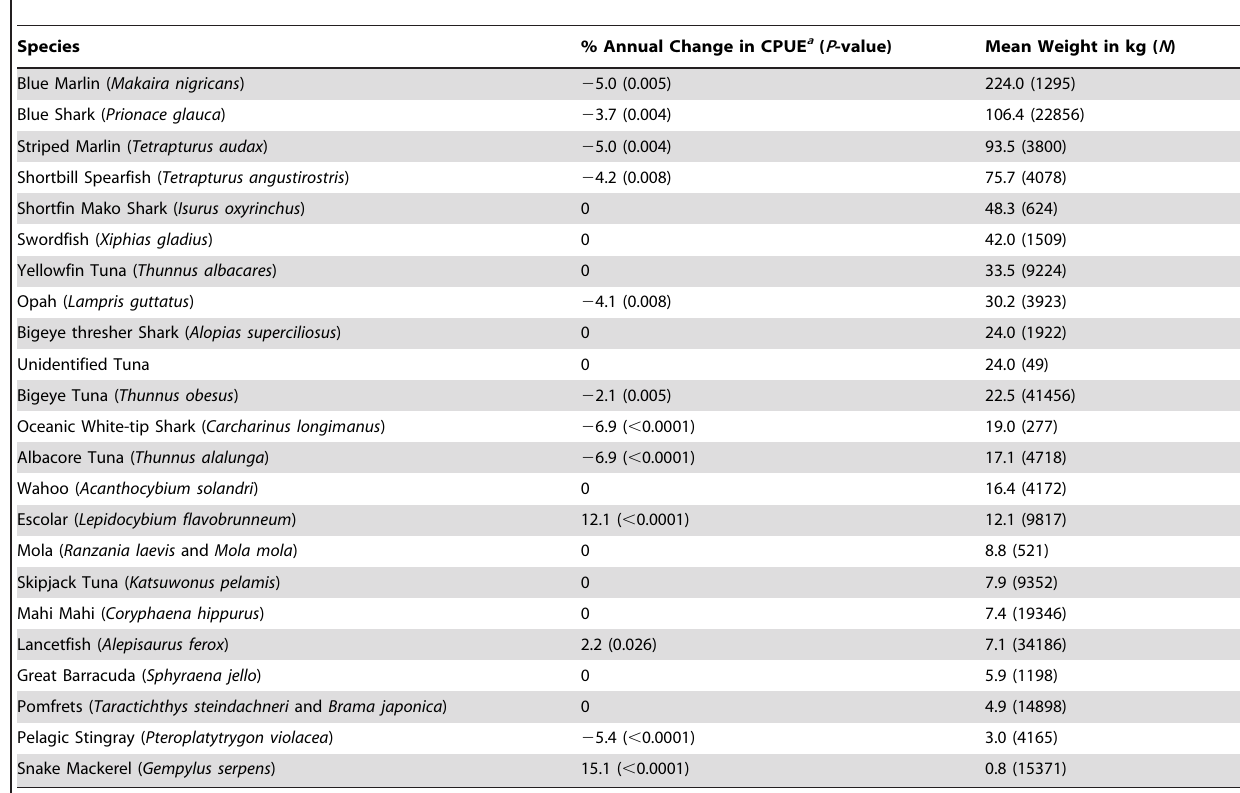
Table 1. Change in catch rate estimated from statistically significant ( P , 0.01) linear regressions over 1996–2011, in order by by fish